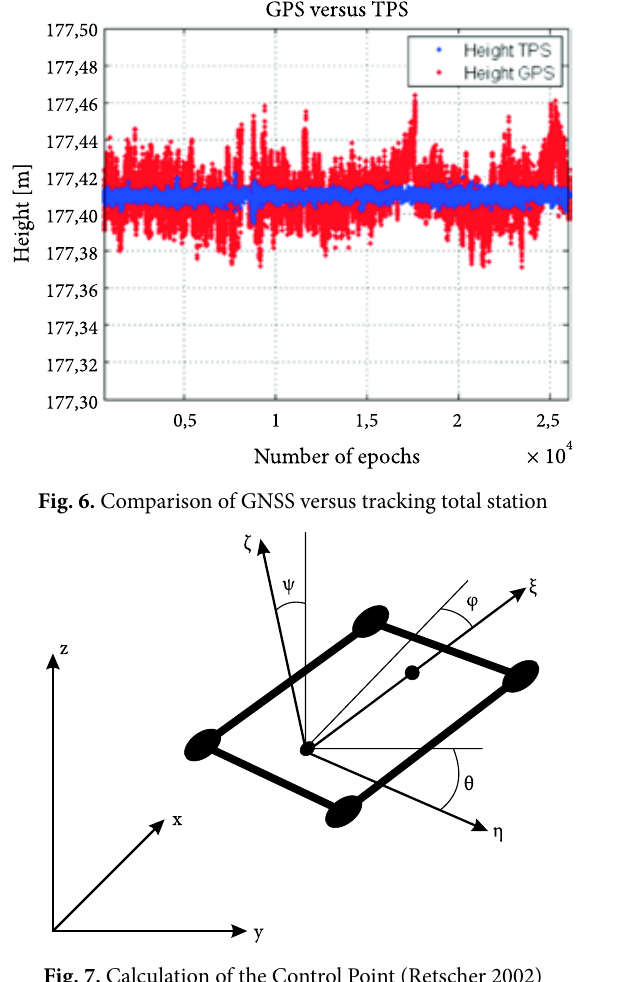
Fig. 7. Calculation of the Control Point (Retscher 2002)